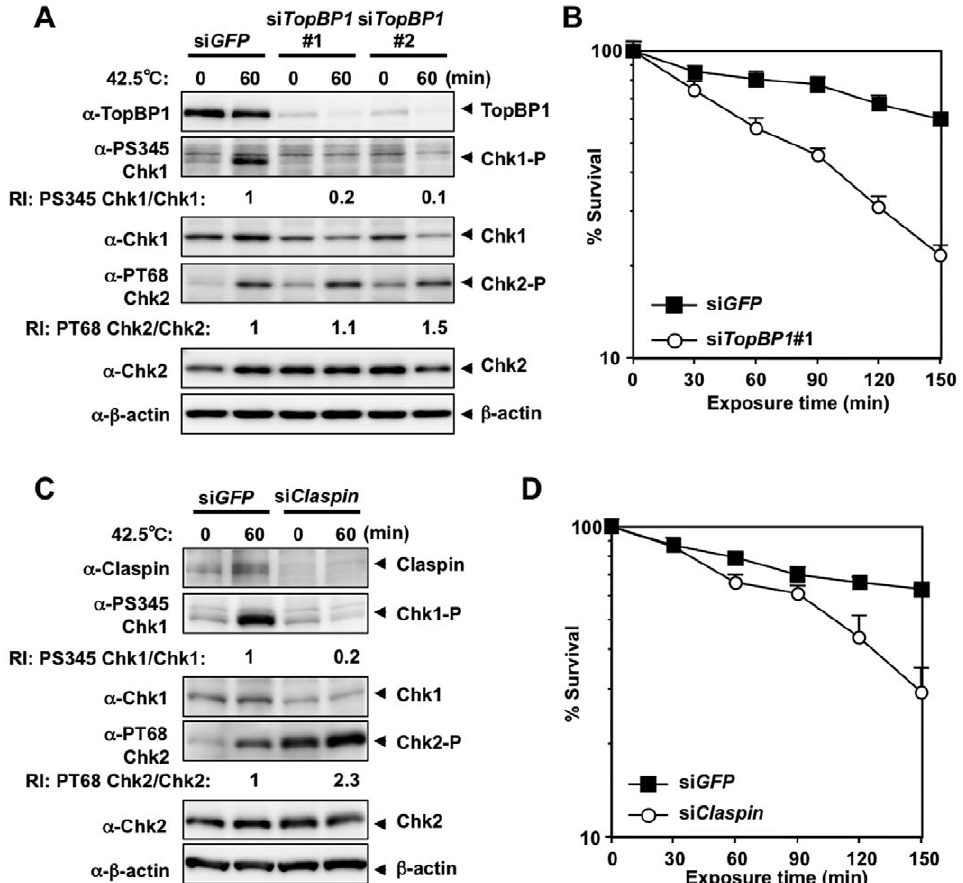
Figure 3. siRNA-mediated knockdown of TopBP1 and Claspin suppressed heat-induced Chk1 Ser345 phosphorylation and enhanced heat cytotoxicity. A. Western blot. HeLa cells were transfected with siRNA for GFP, TopBP1 # 1 or TopBP1 # 2 and cultured at 42.5 u C for 60 minutes. RI: relative intensity compared to the sample of si GFP and 42.5 u C for 60 minutes. B. Clonogenic survival. HeLa cells were transfected with siRNA for GFP or TopBP1 # 1 and cultured at 42.5 u C for the indicated time. C. Western blot. HeLa cells were transfected with siRNA for GFP or Claspin and cultured at 42.5 u C for 60 minutes. RI: relative intensity compared to the sample of si GFP and 42.5 u C for 60 minutes. D. Clonogenic survival. HeLa cells were transfected with siRNA for GFP or Claspin and cultured at 42.5 u C for the indicated